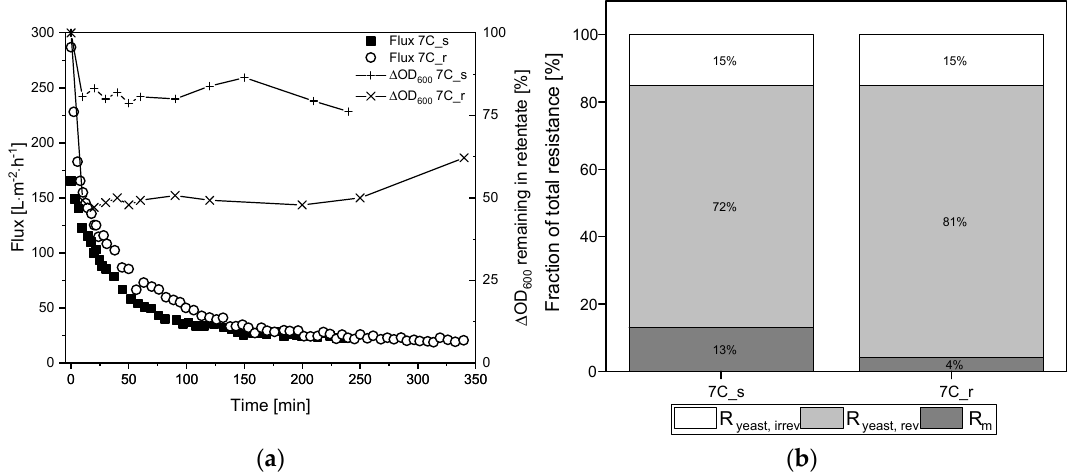
Figure 7. Filtration flux curves and calculated percentage resistances of K. lactis cells (TMP = 0.5 bar, CFV = 0.8 m s − 1 , temperature = 25 °C) using 30 nm tubular UF membranes 7C_s and 7C_r. ( a ) The flux curve (J ss after 240–350 min) and the remaining biomass in the retentate. ( b ) Partition of resistances caused by the filtration of yeast cells. The sum of the reversible and irreversible resistance is R yeast . The sum of R m and R yeast is R yeast, tot . The 100% values correspond to a total resistance R yeast, tot of 7.08 × 10 12 m − 1 for 7C_s, and 8.79 × 10 12 m − 1 for 7C_r.